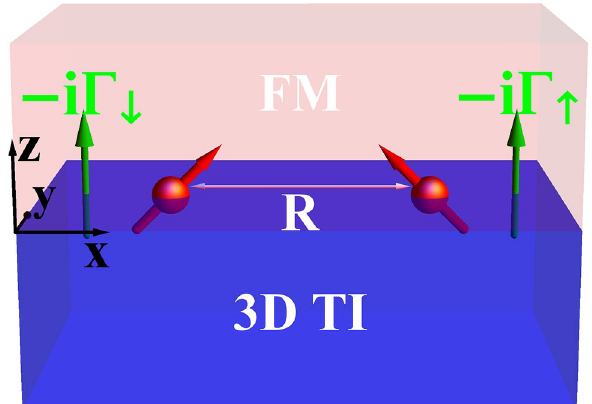
Figure 1. (Color online) Heterostructure consisting of a 3D topological insulator coupled to a ferromagnetic metal. There are two magnetic impurities at the interface that are separated by a distance R . The system is also influenced by the Zeeman exchange field and spin dependent decay rates Ŵ